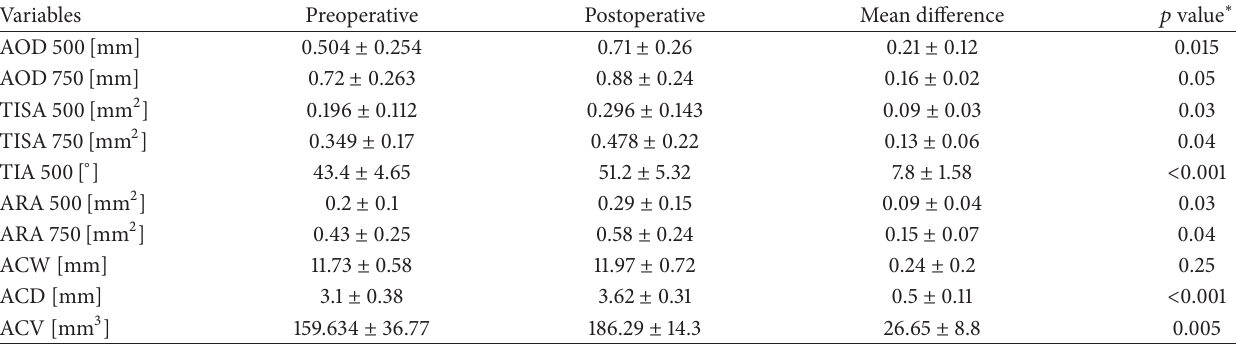
Table 2: Comparison of the angle measurements with swept source OCT before and after combined Trabectome-cataract surgery. Variables